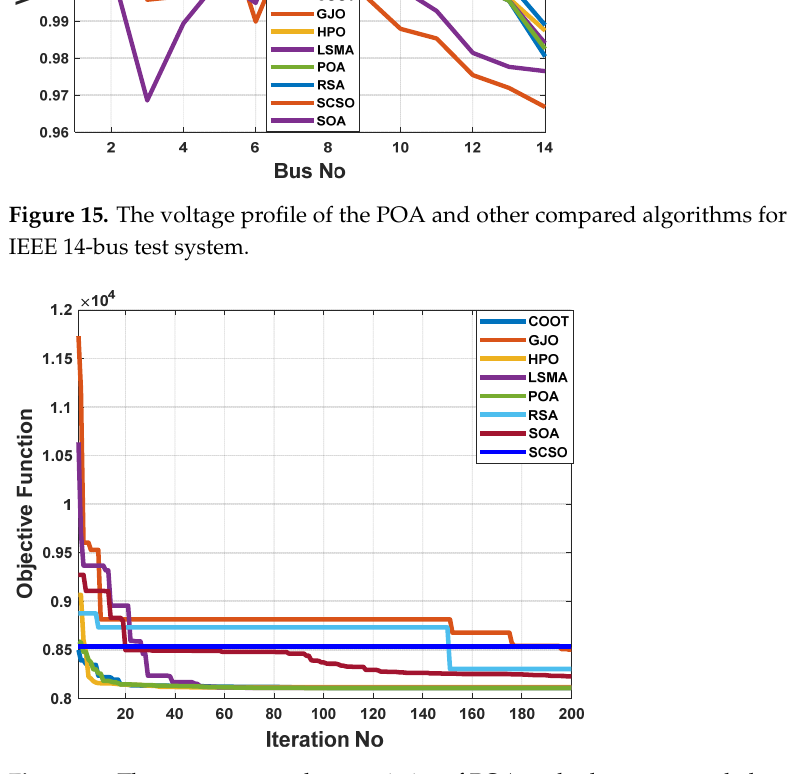
Figure 17. Boxplot of POA and other compared algorithms for case 5 in a standard IEEE 14-bus test system. 3.2. Standard IEEE 57-Bus Test System To assess the scalability of the suggested methods, a large-scale IEEE 57-bus test sys- tem is taken into consideration. Approximately 1975.9 megawatts are the total capacity of this system as illustrated in Figure 18. This system is made up of seven generators located at buses 1, 2, 3, 6, 8, 9, and 12, and 80 transmission lines. Case 1: Fuel Cost Minimization When using the POA algorithm, fuel cost reduction is a target function. Figure 19 depicts the convergence graph of fuel cost reduction using the POA algorithm. The ap- proach needs 40 iterations to get the optimal solution, demonstrating the remarkable con- vergence rate of the POA algorithm. Table 7 lists the optimal cost-minimization values and the appropriate changes to the design variables. Using the POA algorithm, the find- ings show a significant reduction in fuel costs to 40687.44 dollars/h. Additionally, for this scenario, the average computing time for a single loop is 2.3 s. These results demonstrate how the POA algorithm performs well in terms of solution optimality and quick conver- gence. To further verify the effectiveness of the POA method, the fuel cost determined by different alternative heuristic optimization techniques is compared with it. Table 7 shows